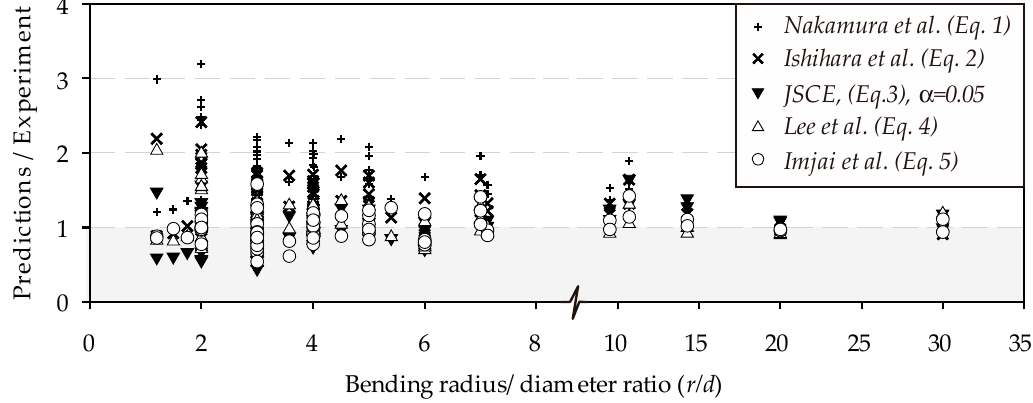
Figure 9. Prediction of experimental tests using existing code provision and models.